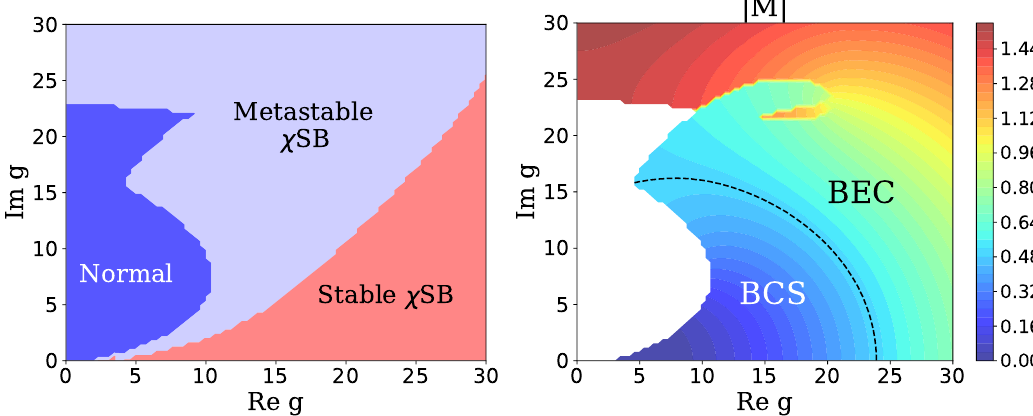
Figure 4. The phase diagram for mass | M | (right). The dashed black line represents | M | =